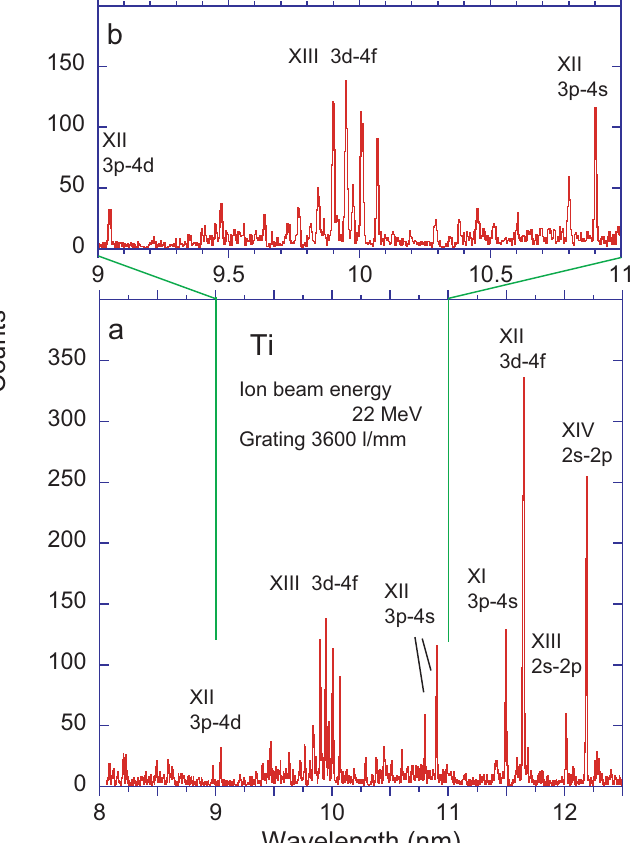
Figure 2. Beam–foil spectrum of Ti observed at an ion beam energy of 22 MeV. Diffraction grating groove density 3600 L/mm, line width (FWHM) of 0.006 nm. ( a ) Survey spectrum; ( b ) expanded detail of the same. The strongest transitions in the spectrum are identified by the spectrum number and transition array. Compare to Figure 1 of